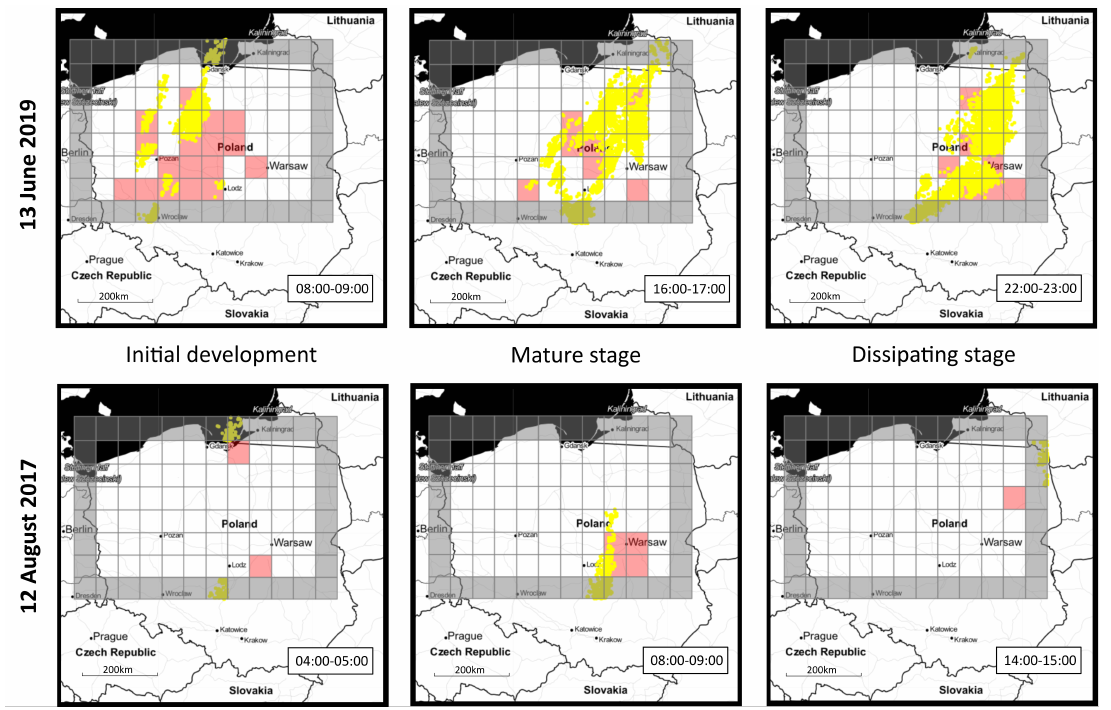
Figure 6. Storm predictions for 13 June 2019 and 12 August 2017. Observed discharges are indicated by the yellow dots. The red voxels show storm predictions. Table 4. Confusion matrix of reported and predicted storm and no storm case for three case